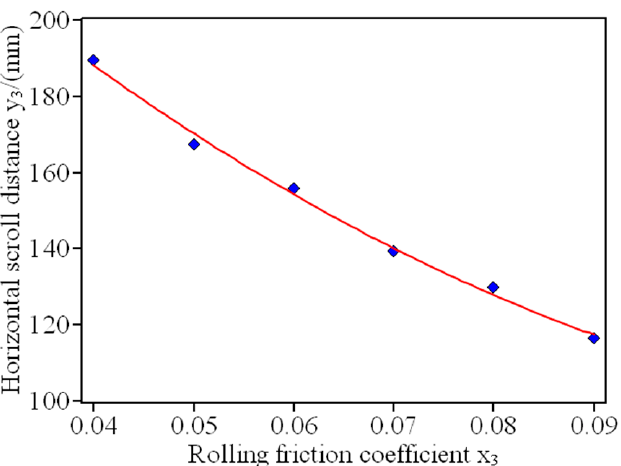
Figure 8. The fitting curve of horizontal rolling distance and rolling friction coefficient in the simulation experiment.